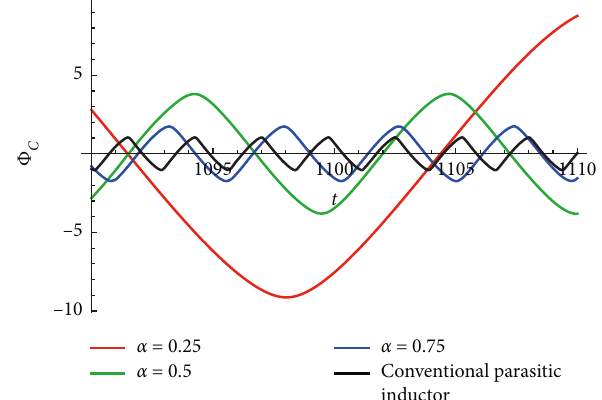
Figure 19: Φ C vs t the memristor-capacitor circuit with the nonlinear parasitic fractional inductor/nonlinear conventional parasitic inductor.